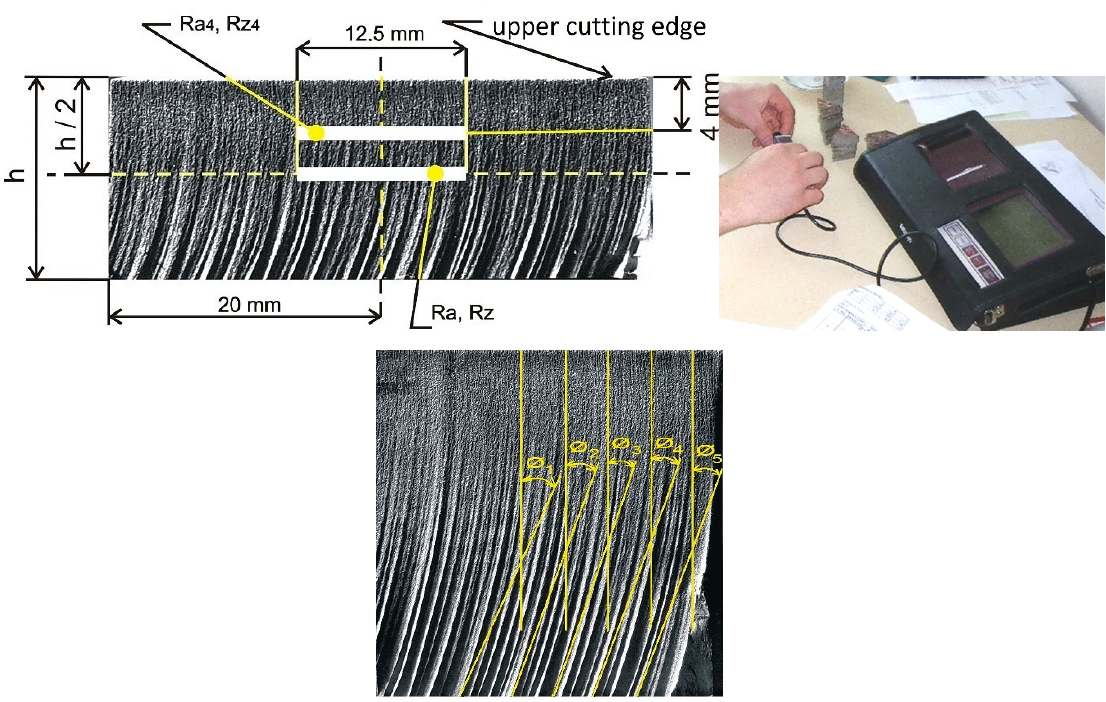
Figure 4. Locations of zones for measuring roughness parameters Ra, Rz , and Ra 4 , Rz 4 ( upper left ); measurement of roughness Ra, Rz , and Ra 4 , Rz 4 on cut surfaces of samples ( upper right ); declination angle on the cut surface ( bottom ).